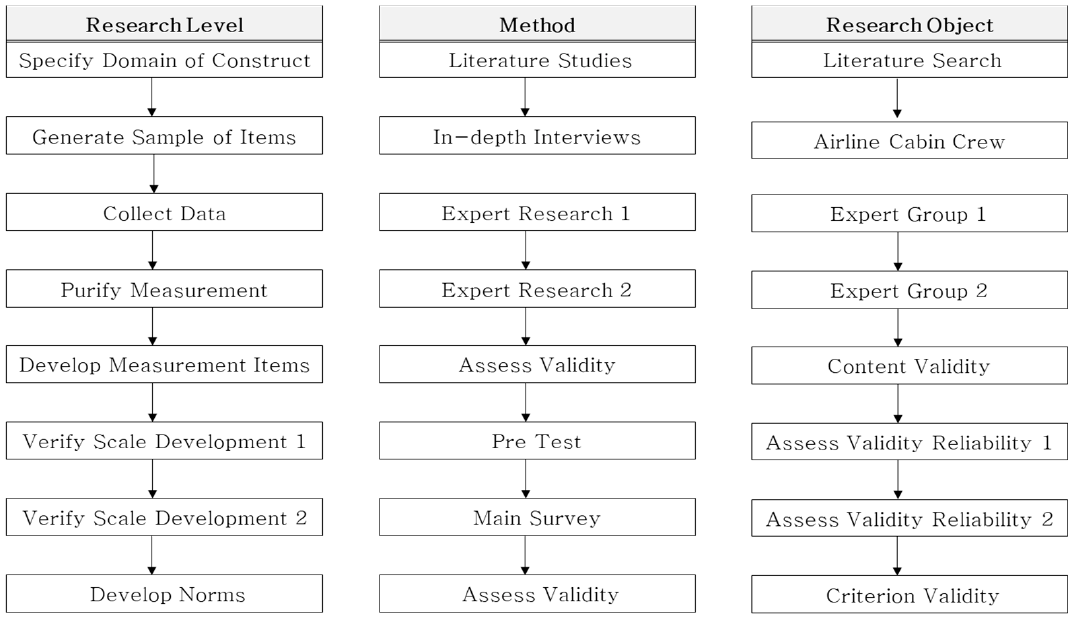
Figure 1. Research procedure.